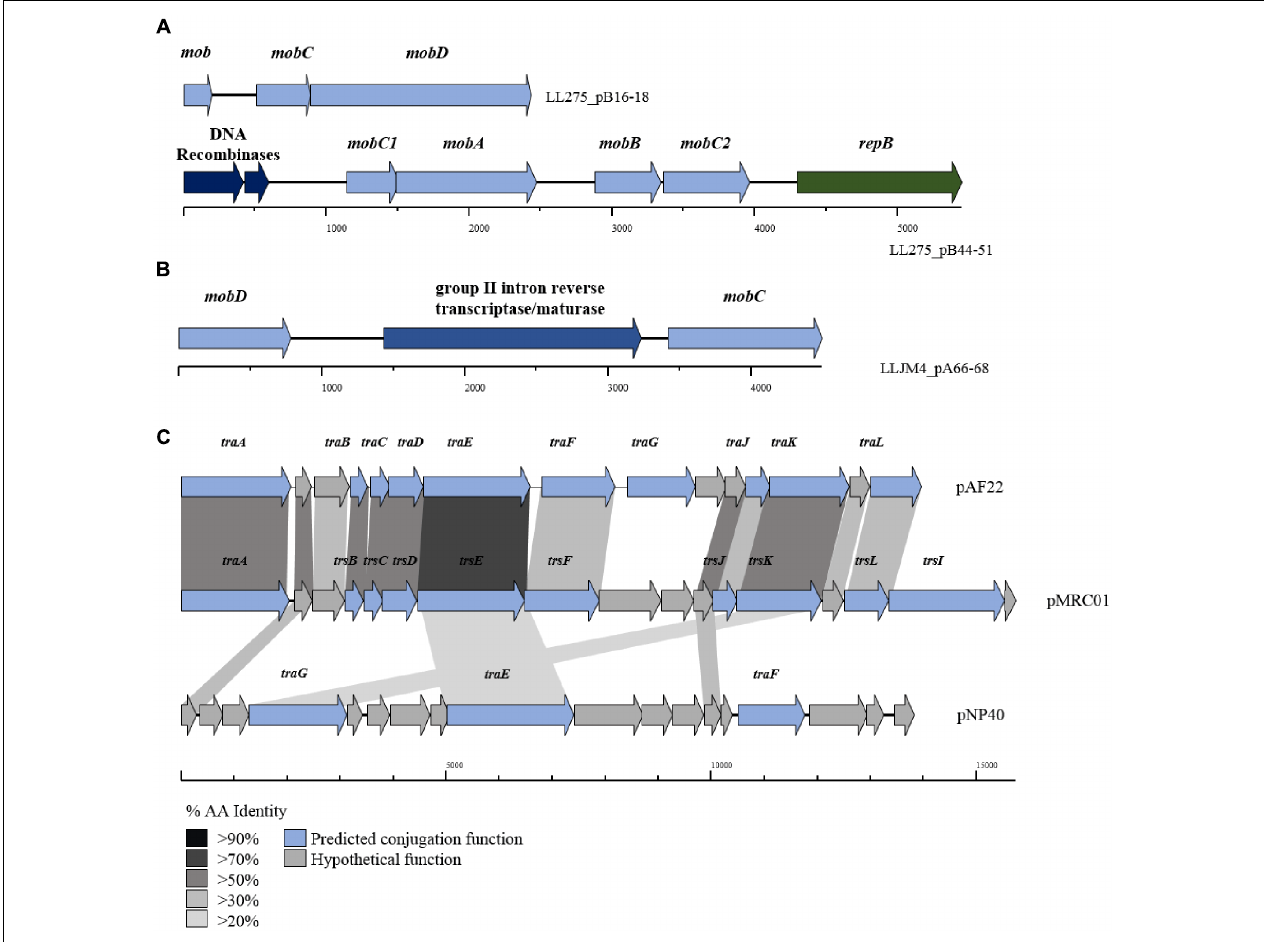
FIGURE 4 | BLAST map of active lactococcal conjugation gene clusters. The image describes the genetic organization of mob genes in (A) p275B, (B) pJM4A, and (C) the conjugation gene clusters from plasmids pAF22, pMRC01, and pNP40. All three plasmids have previously been shown to be self-transmissible by conjugation. Gene synteny is highly conserved between pAF22 and pMRC01, but amino acid identity is not, while pNP40 represents a divergent system. Amino acid identity is indicated by the shaded boxes. Arrows colored blue indicate predicted conjugative function, while arrows shaded gray indicate hypothetical